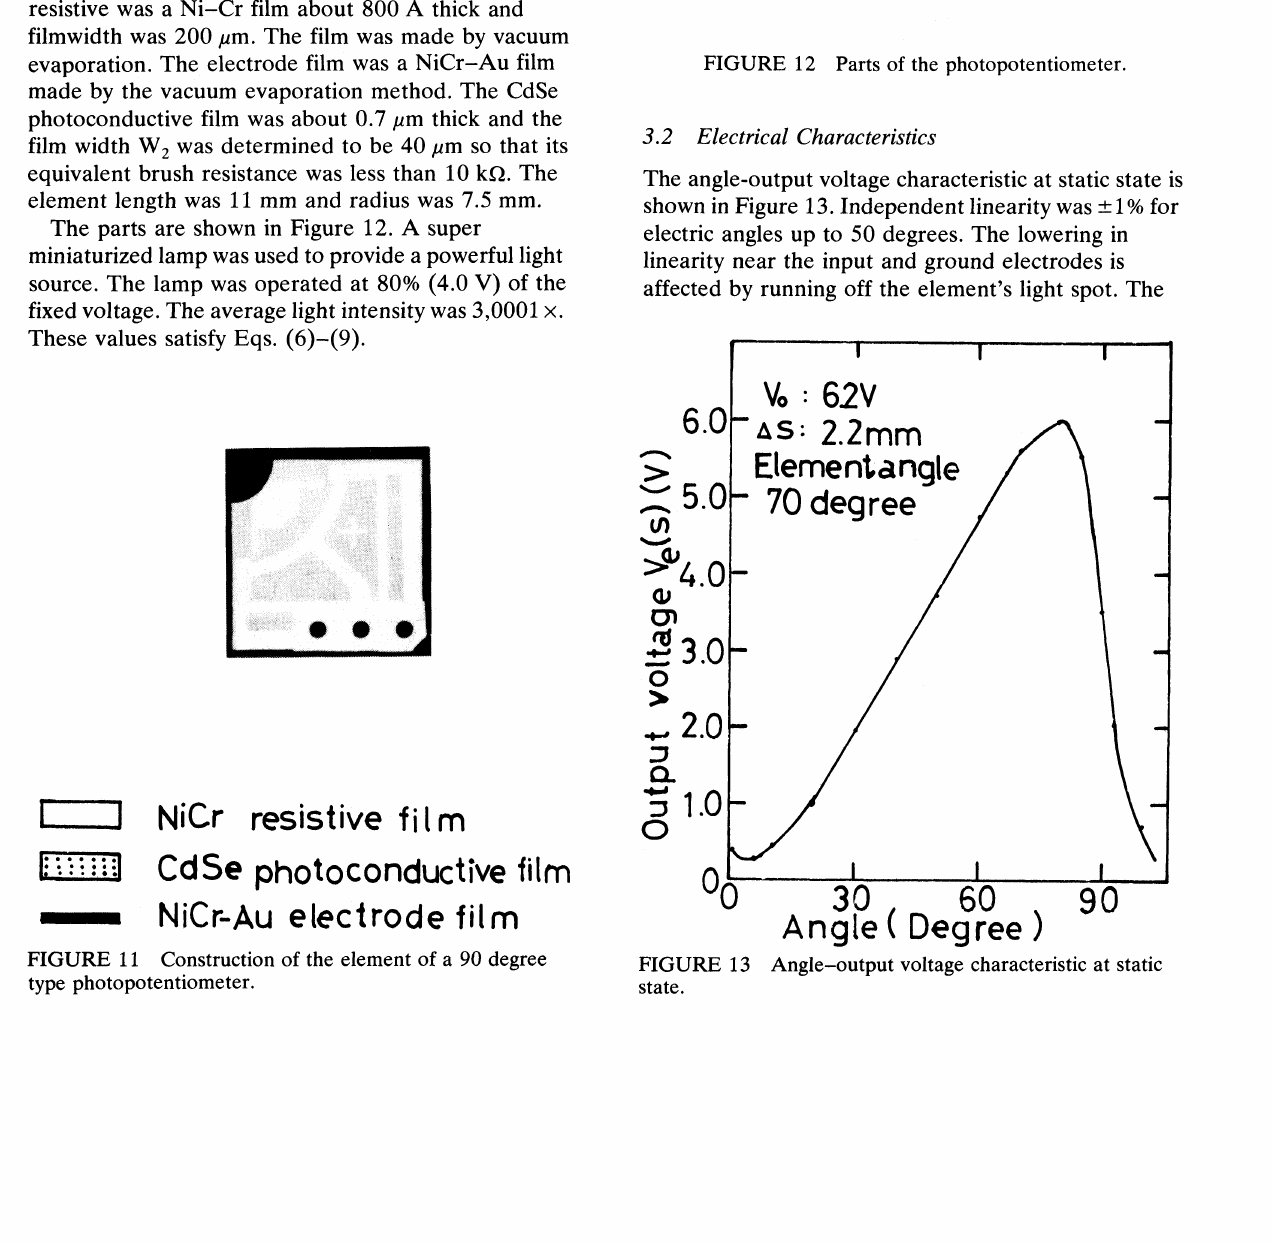
FIGURE 11 Construction of the element of a 90 degree type photopotentiometer.